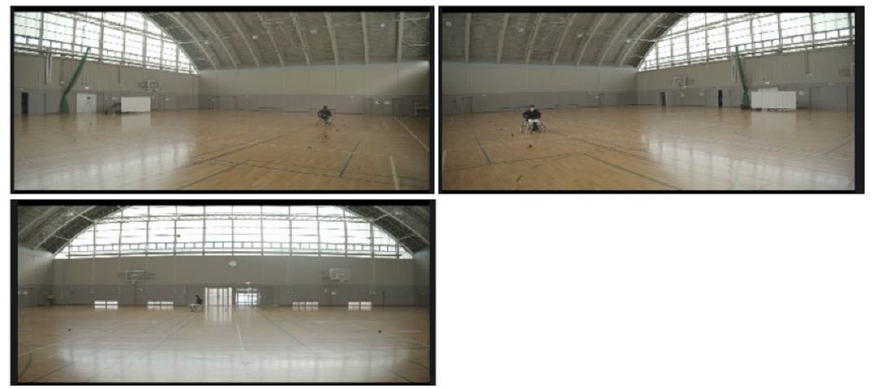
Figure 3. Example of measured camera images.